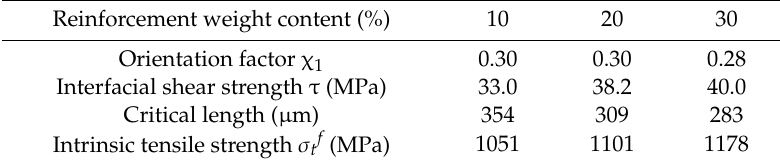
Table 4. Micromechanics tensile strength properties of PA6-based